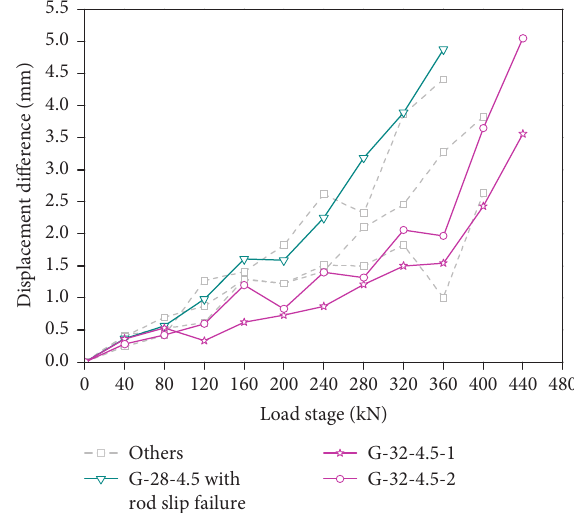
Figure 22: Load-displacement difference curves of the anchors with different rod diameters. It should be noticed that the failure modes of the anchors G-32-4.5-1 and G-32-4.5-1 are all rod slip